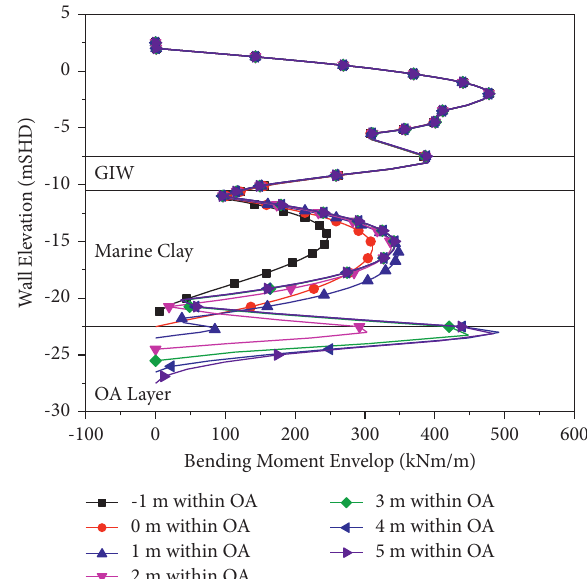
Figure 9: The effect of retaining wall embedded length into OA on wall bending